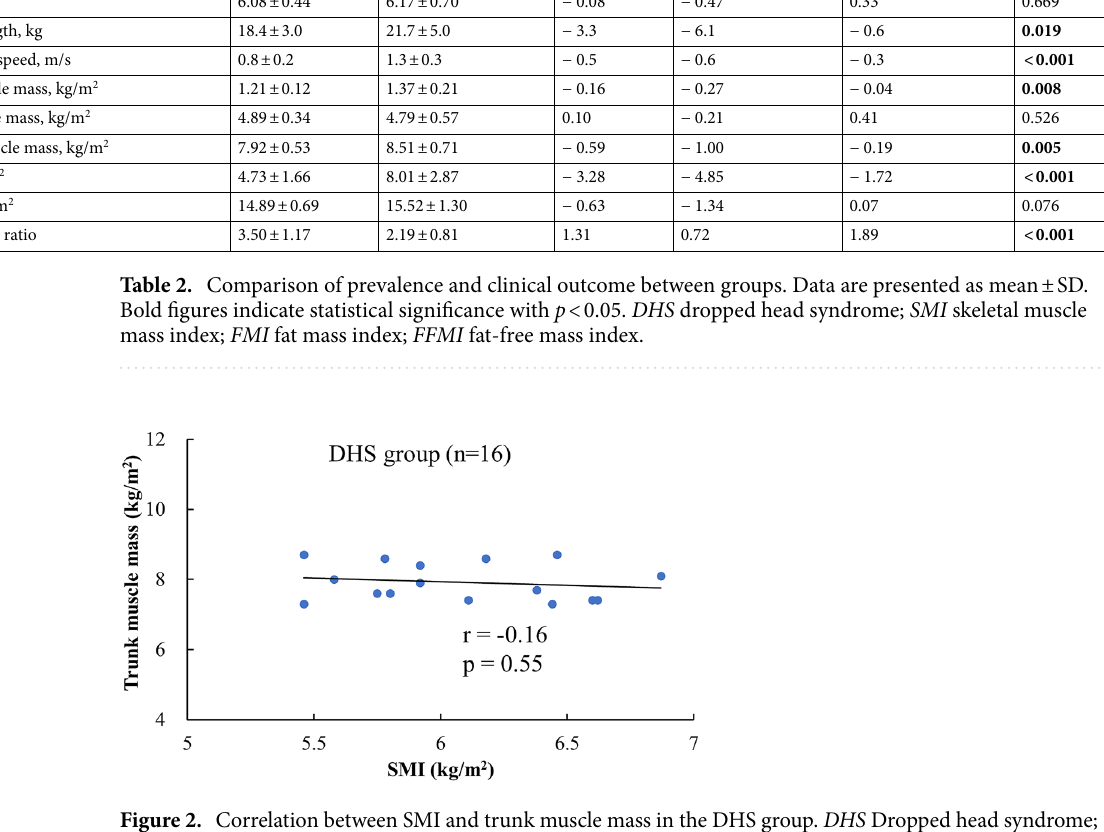
Figure 2. Correlation between SMI and trunk muscle mass in the DHS group. DHS Dropped head syndrome; SMI skeletal muscle mass